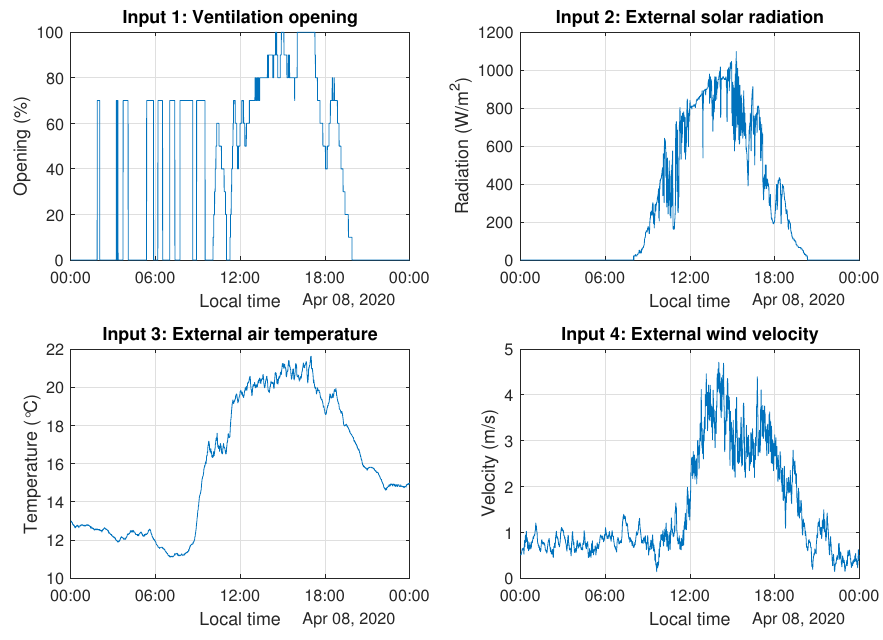
Figure 7. Inputs for ARX model identification.